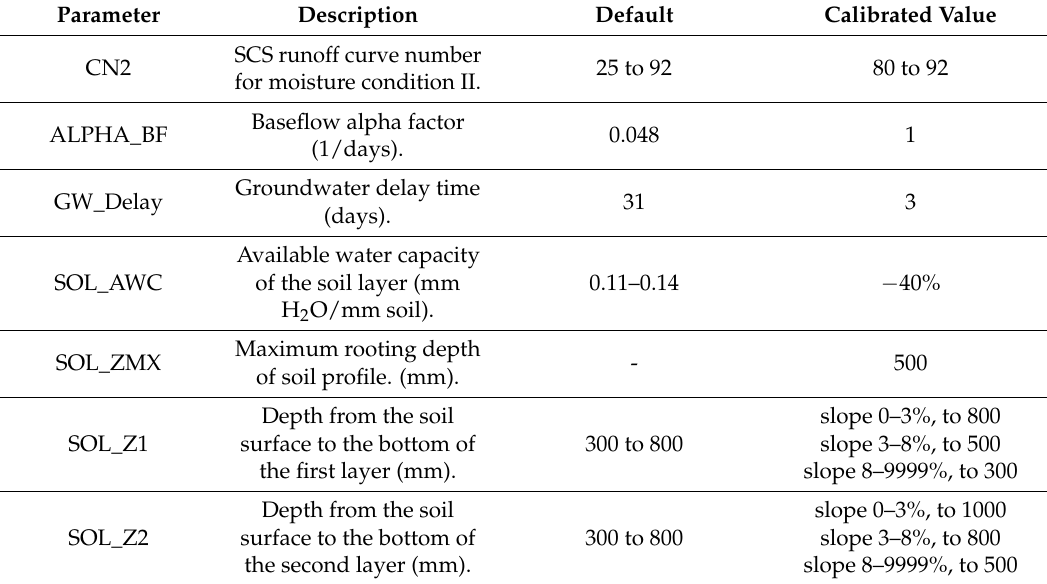
Table 2. The values of the calibrated parameters used in the SWAT model (parameter, description and default according to Neitsch et al.